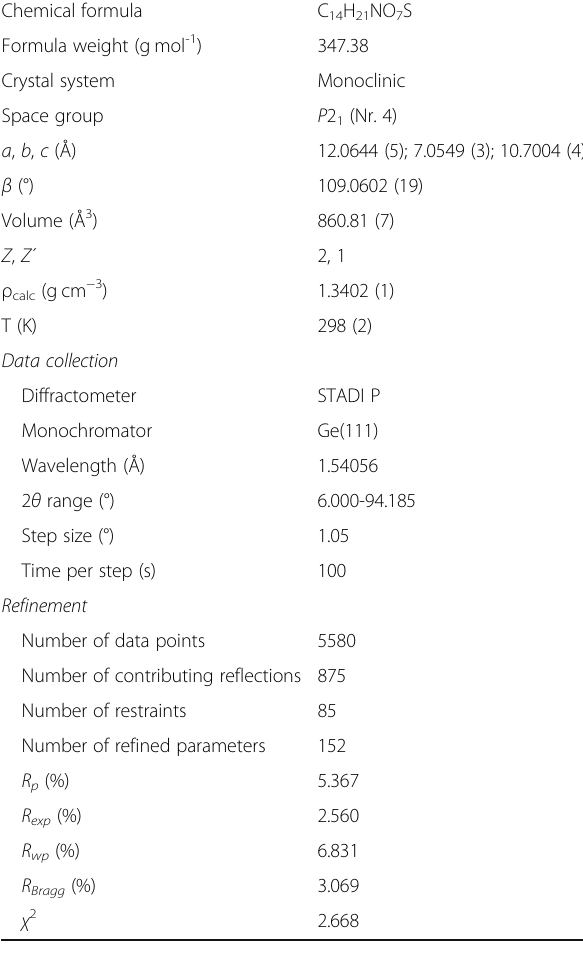
Table 2 Details from the Rietveld refinement of the crystal structure of